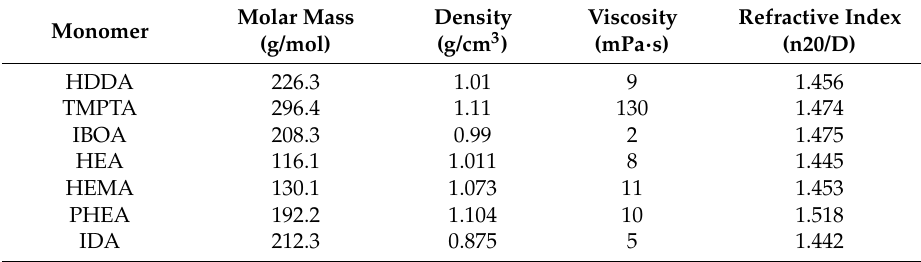
Table 1. Typical properties of the monomers selected for evaluation in this study at 20 ◦ C. Molar Monomer